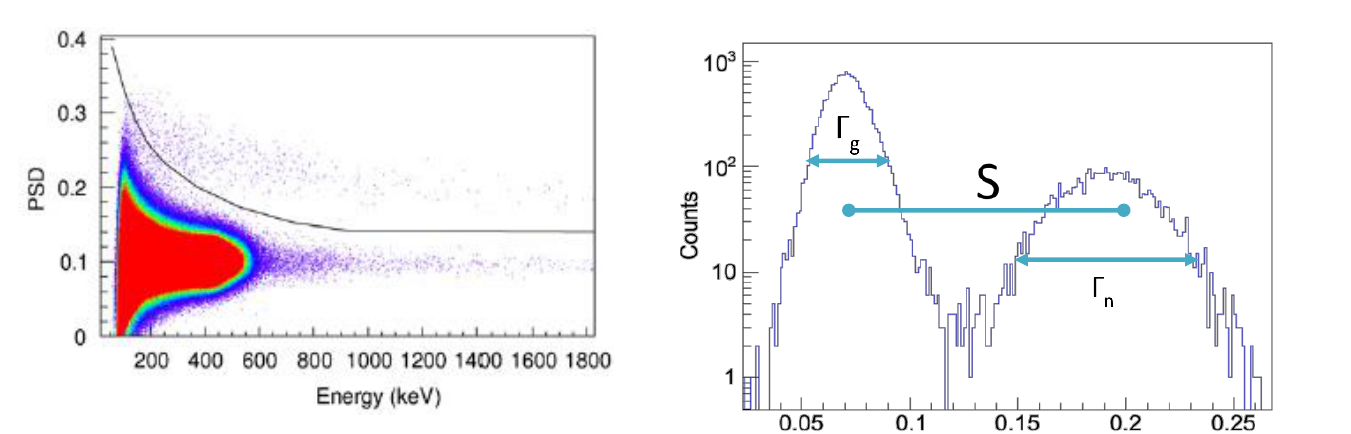
Fig. 2. . Neutron-Gamma discrimination with gamma dose rate of 0.1 mSv/h on the front face of the detector. The black line is a polynomial function used to separate the gamma region from the neutron region. Pulse Shape Discrimination Plot obtained by a CAEN desktop digitizer with a EJ309 liquid scintillator detector coupled to a flat panel Hamamatsu.